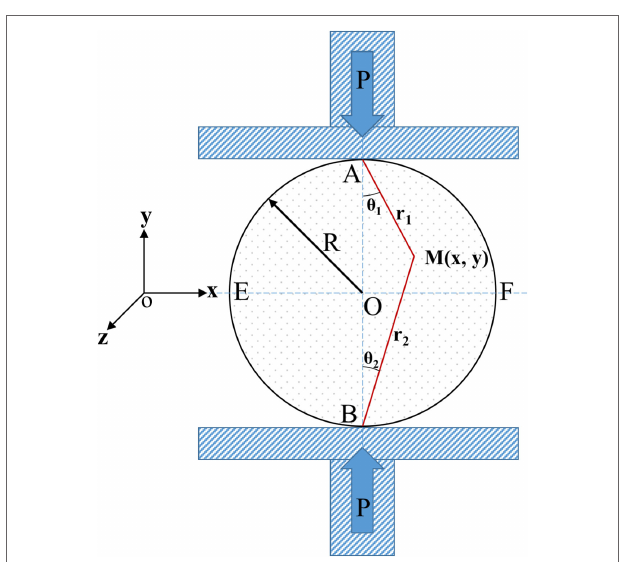
FIGURE 1 | A cylinder shape sample subjected to compression load P